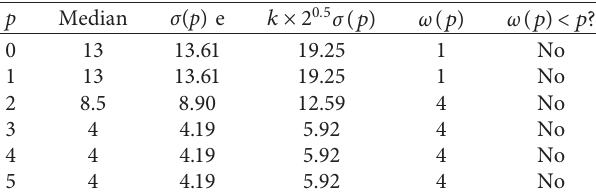
Table 8: step estimations for the investigation with the edge plan.